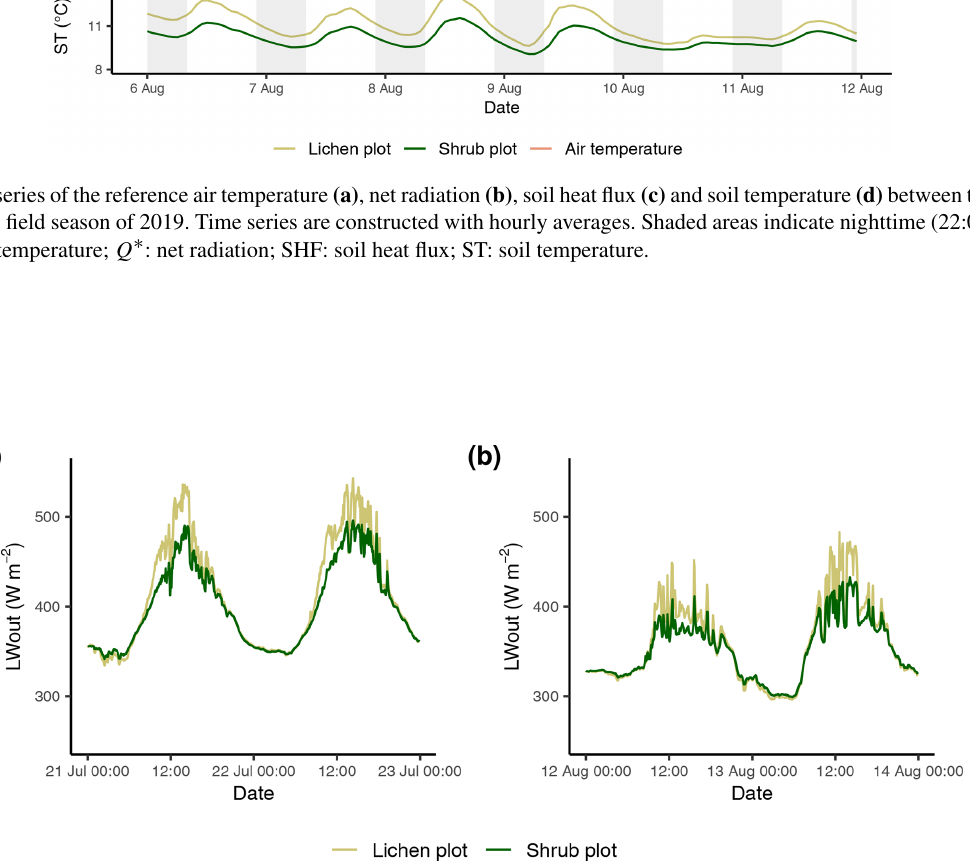
Figure F1. Time series of the outgoing longwave radiation of the paired lichen and shrub plots measured on 21 and 22 July 2018 (a) and on 12 and 13 August 2018 (b)